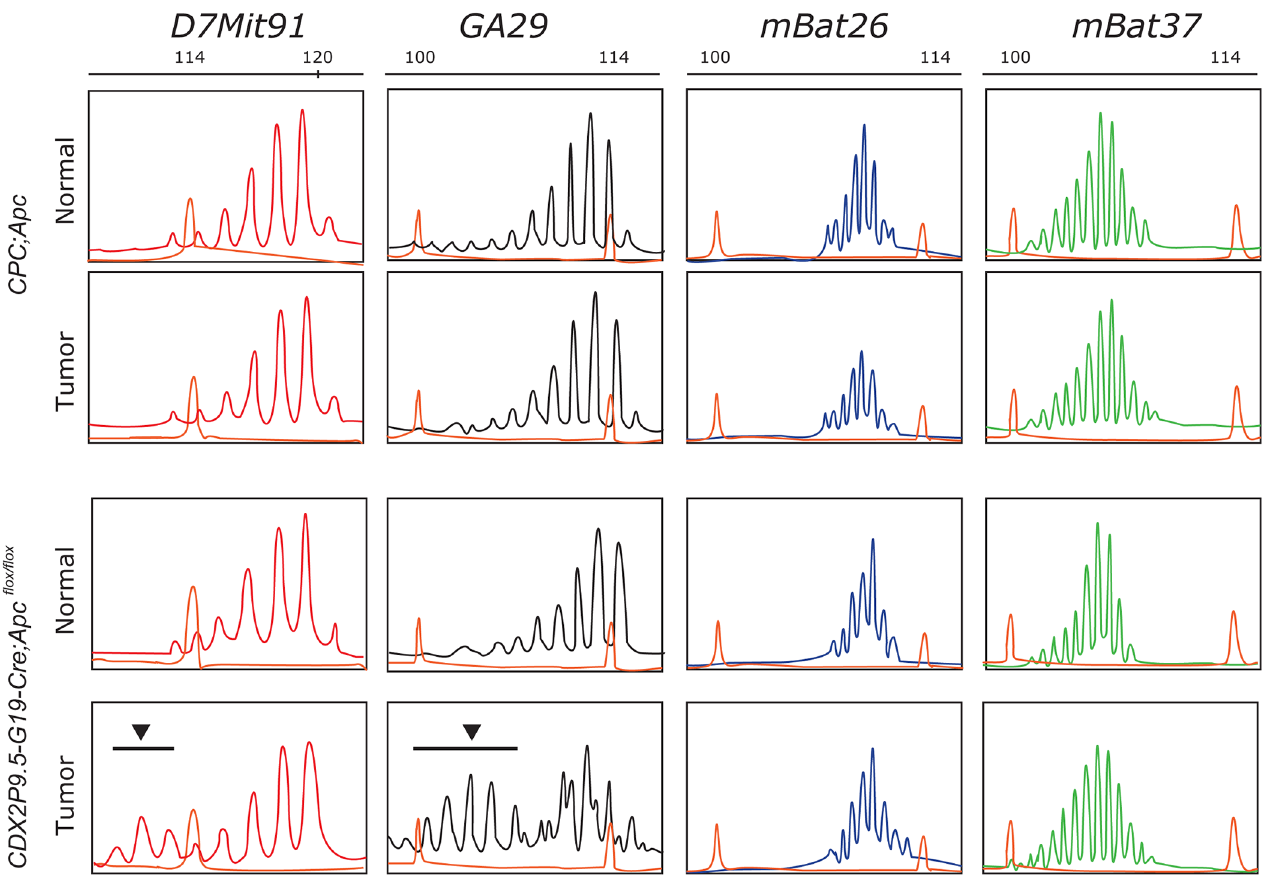
Fig 3. MSI in tumors from CPC;Apc and CDX2P9 . 5-G19Cre;Apc flox/flox mice. Tumors from CDX2P9 . 5-G19Cre;Apc flox/flox mice showed a hypermutable phenotype (arrowhead and black bar) for two ( D7Mit91 and GA29) of four markers investigated, suggesting that tumor development occurs via MSI. The 600 LIZ size standard (Eurofins GeneScan, Frieburg, Germany) was used as a marker for sizing DNA fragments.